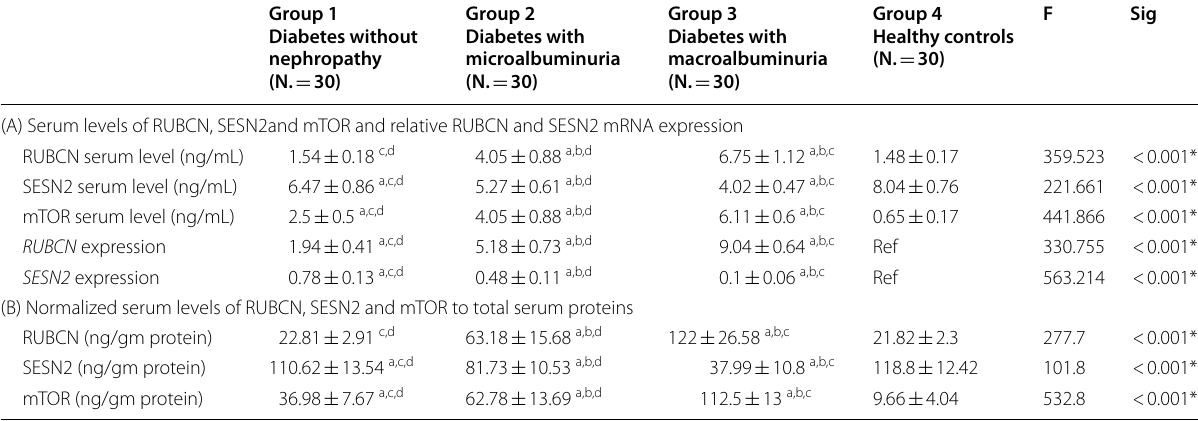
ANOVA analysis with post hoc Tukey’s test; (*) indicates statistical significance), data is presented as mean a Significant p value (< 0.05) compared to controls (group 4) b Significant p value (< 0.05) compared to group 1 c Significant p value (< 0.05) compared to group 2 d Significant p value (< 0.05) compared to group 3 RUBCN: Rubicon; SESN2: Sestrin-2; mTOR: mammalian target of Rapamycin